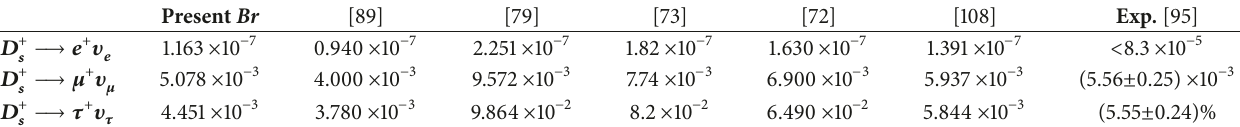
Table 14: Leptonic branching ratio of 𝐷 + 𝑠